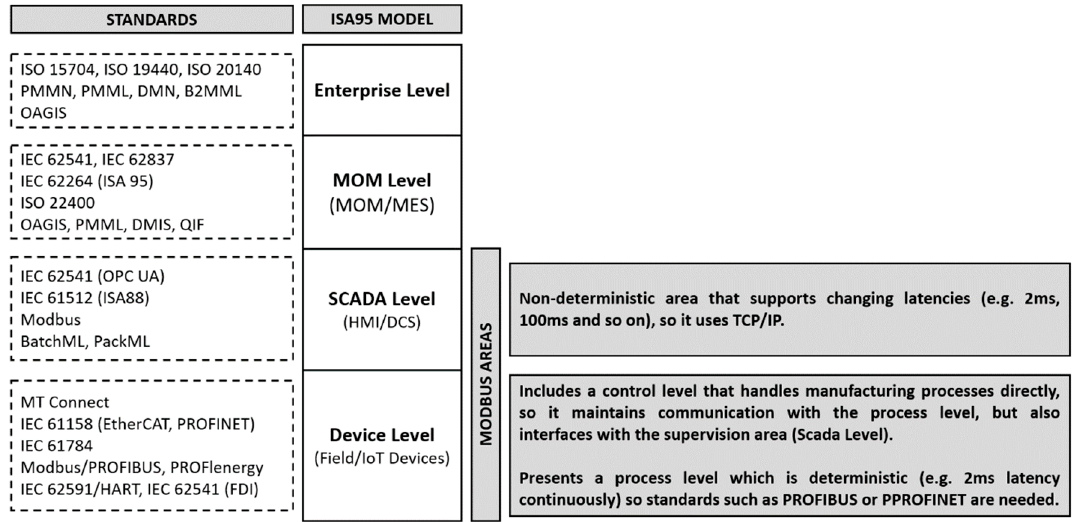
Figure 1. Action fields of Modbus based on the ISA 95 model and related standards [3,4].